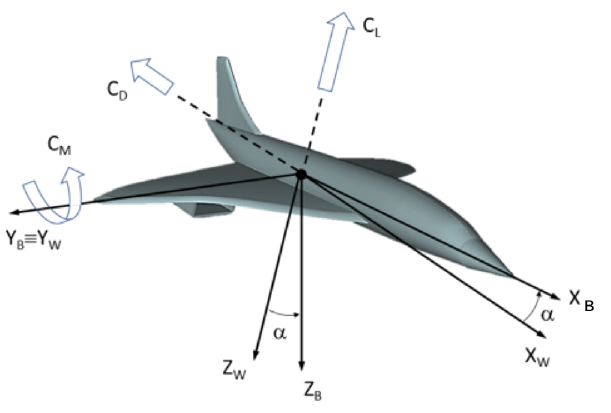
Figure 5. Body ( X B , Y B , Z B ) and wind ( X W , Y W , Z W ) reference frames. The contours of the pressure distributions that take place over the aircraft leeside at α = 0 ◦ , 10 ◦ , 20 ◦ , 30 ◦ are shown in Figure